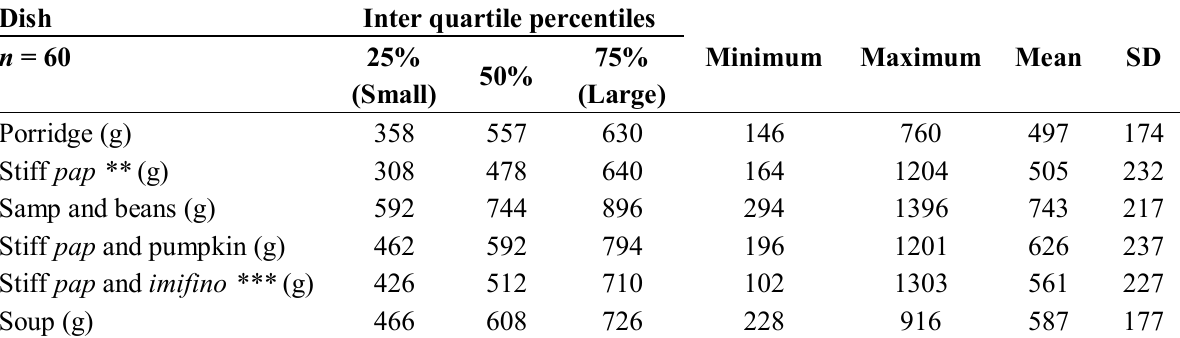
Table 4. Portion sizes of six main maize dishes calculated during the dishing-up sessions ( n = 35) *.